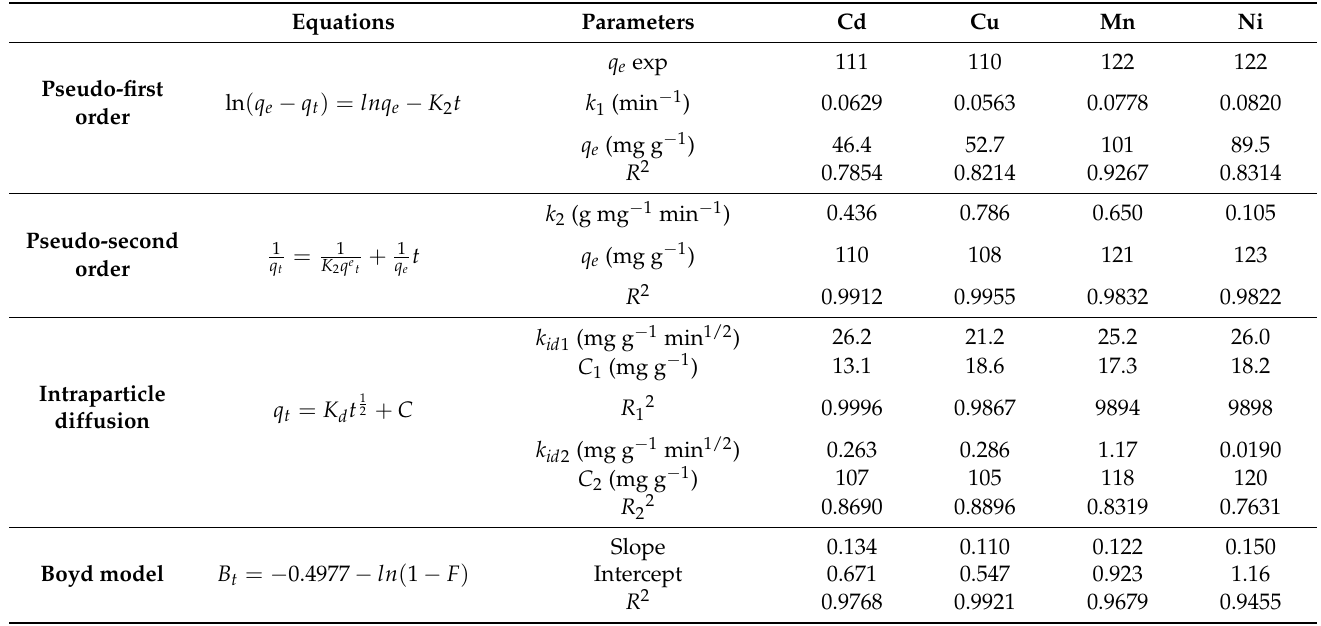
Table 4. Pseudo-first order kinetic model, psedo-secondorder kinetic, intraparticle difussion and Boyd models for metal ad-